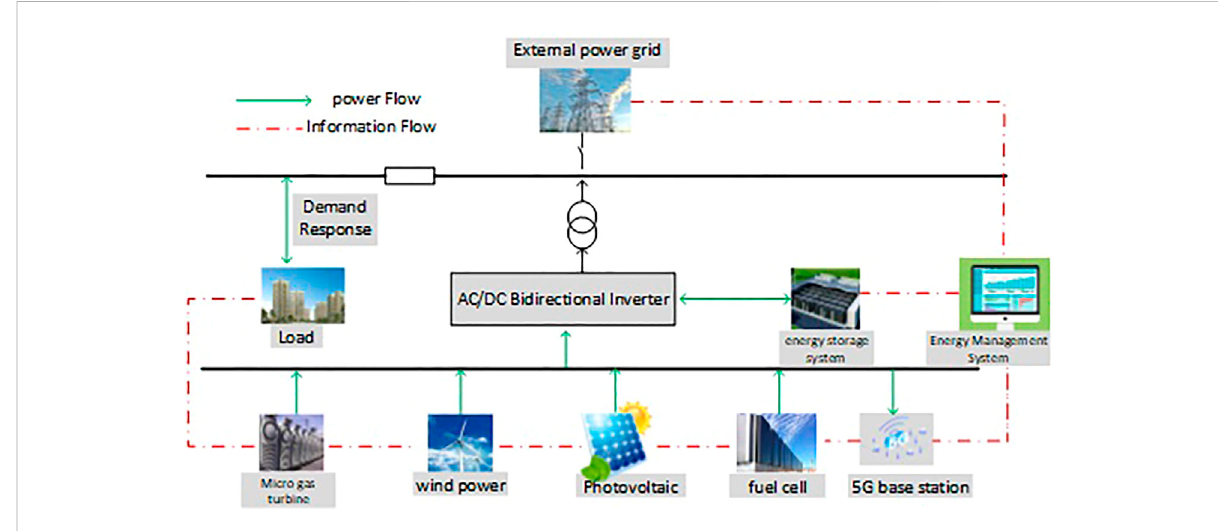
FIGURE 1 Schematic diagram of Microgrid system